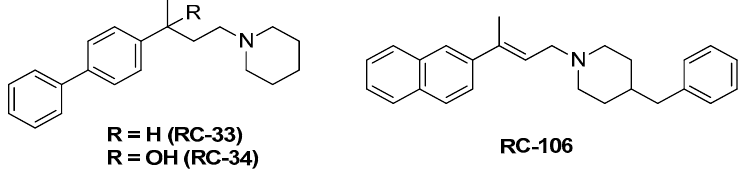
Figure 1. Structures of RC-33, RC-34 and RC-106.